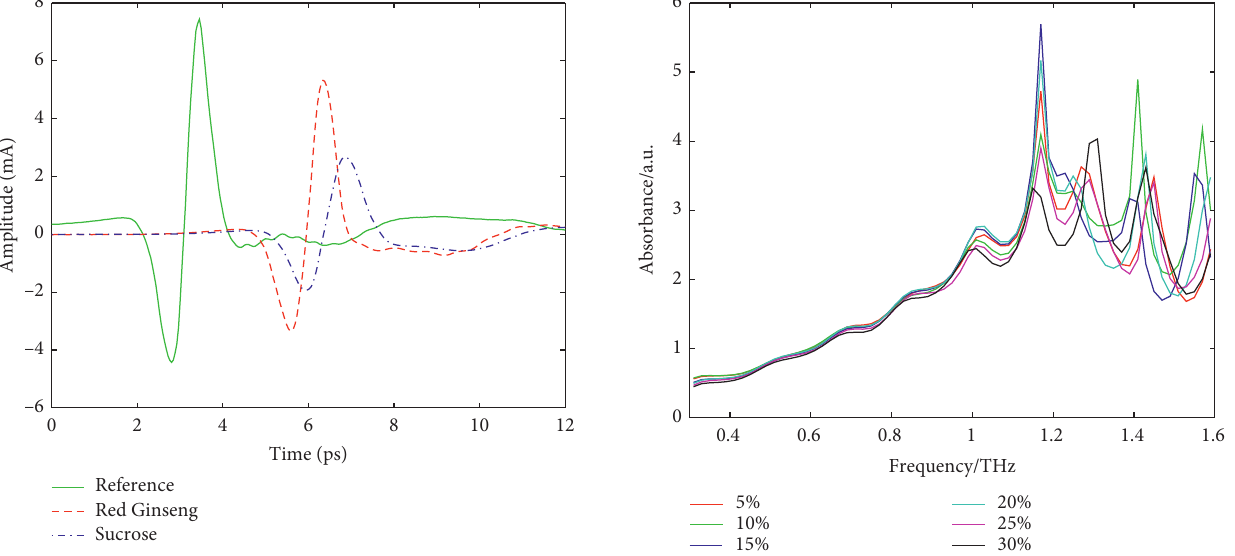
Figure 2: The time-domain spectra of red ginseng and sucrose.